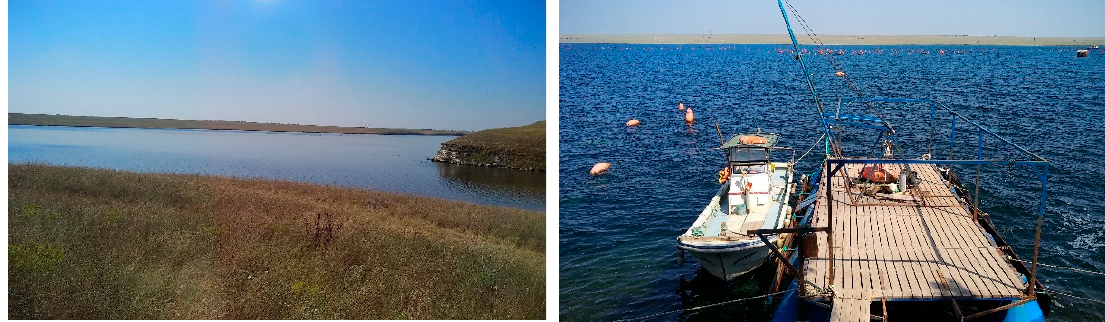
Figure 2. Northern ( A ) and southern ( B ) coasts of the Donuzlav Gulf of the Black Sea.